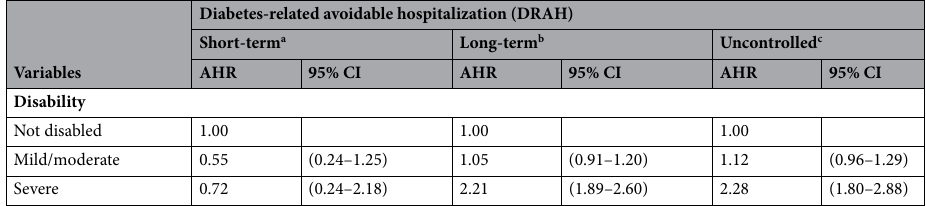
Table 3. Diabetes-related avoidable hospitalization hazard ratio by different indicators, results of Cox proportional hazard model. AHR Adjusted Hazard Ratio. Adjusted for sex, age, region, income, insurance type,